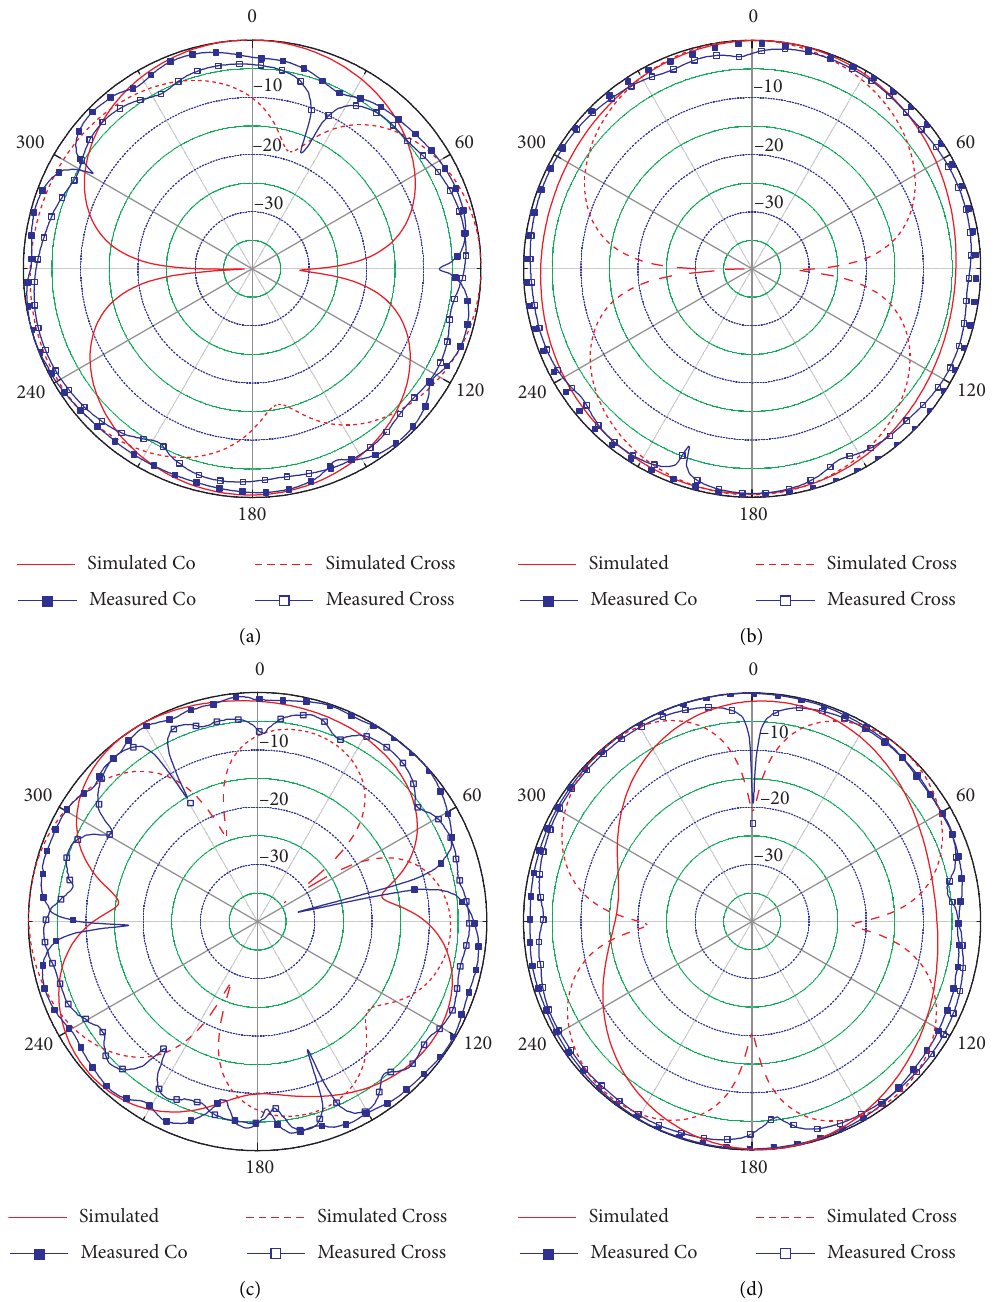
Figure 12: Radiation patterns of antenna: (a) E plane at 2.7GHz, (b) H plane at 2.7GHz, (c) E plane at 5.76GHz, and (d) H plane at